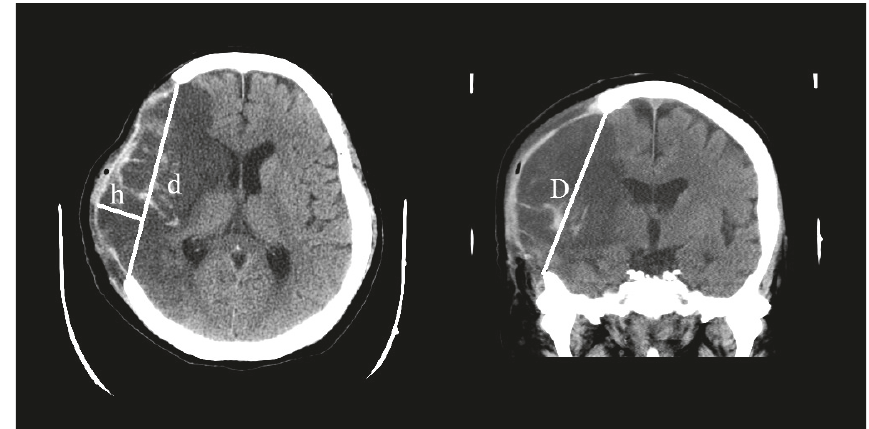
Figure 4: Previous attempts to measure the craniectomy area. The surface area can be estimated using the spherical cap formula: 𝐴 𝑠 = 𝜋[(𝑑/2) 2 + ℎ 2 ] [12, 13]. The base area can be estimated using 𝐴